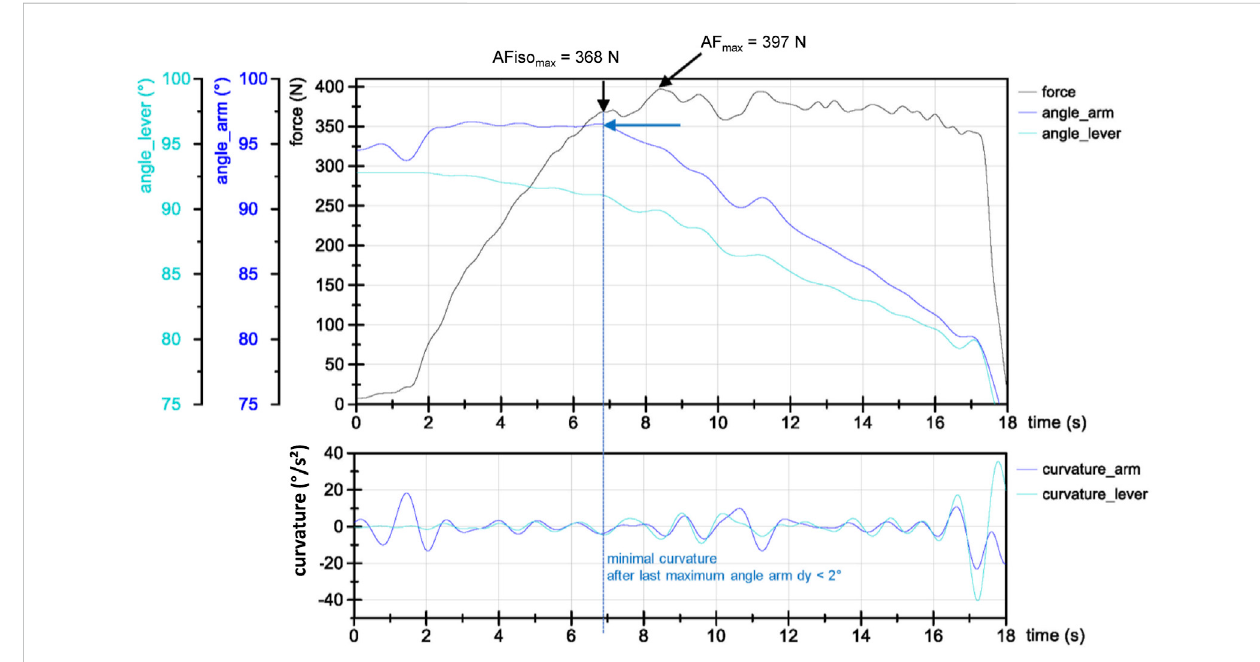
FIGURE 2 Exemplary force (N) and angle signals (in degree, converted from ACC of the forearm (arm, blue) and lever (turquoise) (bottom) and the second derivation of angle signals (curvature; below)) of one AF measurement (second trial) of a strength athlete. AFiso max and AF max are highlighted. AFiso max is theforcevalueattheminimalcurvatureafterthelastmaximuminanglesignal(here,forearm)withdy < 2 ° ,wheretheleverangledoesnotshowapushing action of the participant. After AFiso max , both angle signals decrease with some phases of minor concentric or short isometric